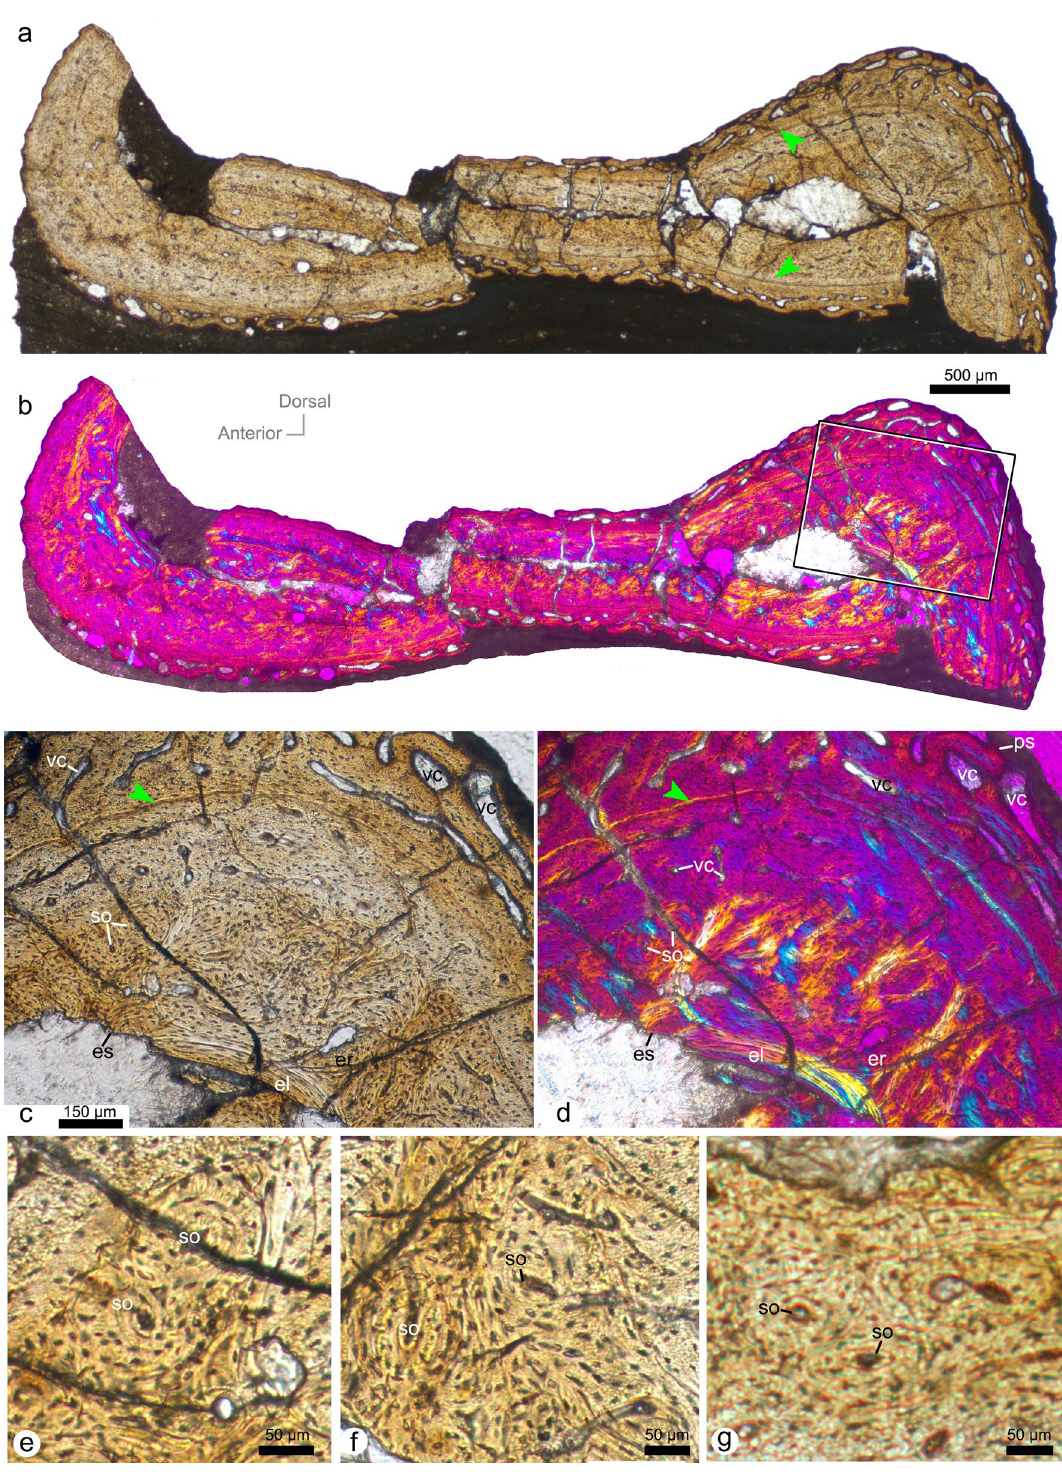
Figure 2. Histological thin-section of the first wing phalanx (SDUST-V1014; 71 µm in thickness). Whole cross- section ( a , b ) and enlarged image ( c , d ) under plain ( a , c ) and cross-polarized light ( b , d ), and higher enlarged images of secondary osteons under plain light ( e – g ). Arrow points to LAG. el endosteal lamella, es endosteal surface, ps periosteal surface, so secondary osteons, vc vascular